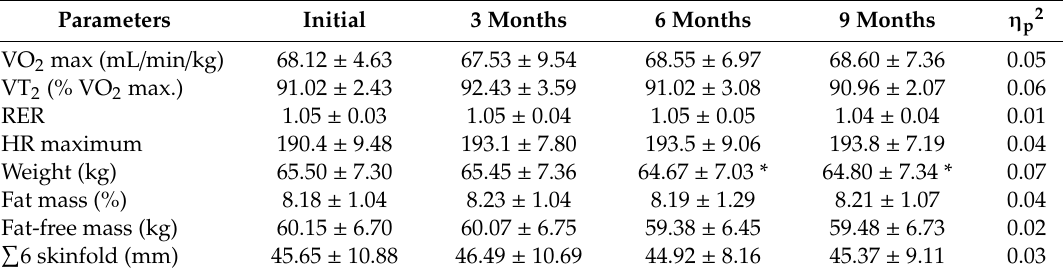
Table 2. Ergospirometric and body composition parameters in the athletes during the season.